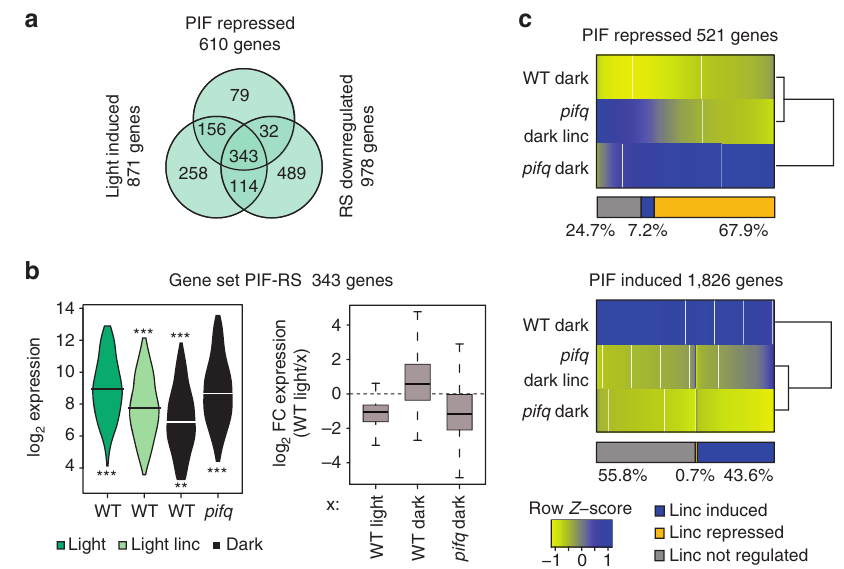
Figure 2 | Retrograde signals repress the light-induced expression of PIF-repressed genes. ( a ) Plastid signals repress the induction of light-induced genes. Overlap among genes downregulated by chloroplast RS 27 , induced by red-light 11 or repressed by PIFs in the dark 11 , identifies 343 genes labelled as ‘Gene-Set PIF-RS’ (gene lists provided in Supplementary Data 1). ( b ) Expression of genes in ‘Gene-Set PIF-RS’ in WTand pifq mutants grown in the light in the absence (dark green) or presence (light green) of lincomycin, or in the dark (black) (left). Fold-change expression of genes in ‘Gene-Set PIF-RS’ between WT light lincomycin with respect to WT light, WTdark or pifq dark (right). Data obtained from refs 11 and 23. Statistically significant differences from WT light or WT light linc by heteroscedastic t -test are indicated in the upper and lower part, respectively (** P o 0.01 and *** P o 0.001). ( c ) Lincomycin extensively restores the PIF-repressed network in pifq in the dark to the WT levels. Two-dimensional-cluster diagram depicting expression levels of 521 PIF-repressed (top) and 1,826 PIF-induced (bottom) SSTF genes in the dark in the absence (dark) or presence (dark linc) of lincomycin. Genes were identified by transcriptomic profiling of seedlings grown for 3 days in the dark in the absence (dark) or presence (dark linc) of